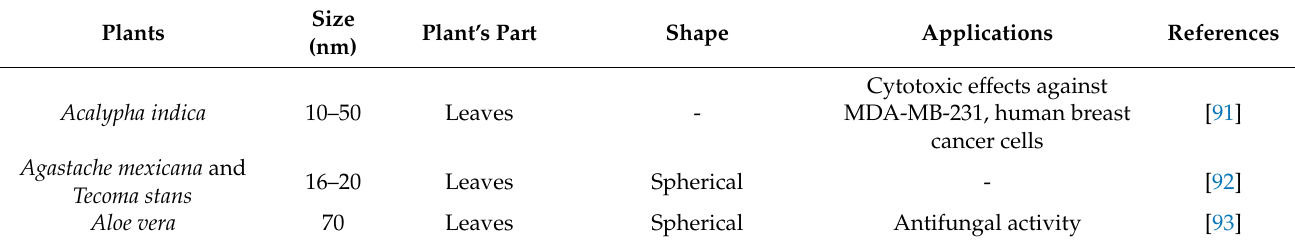
Table 1. Silver nanoparticles synthesized using